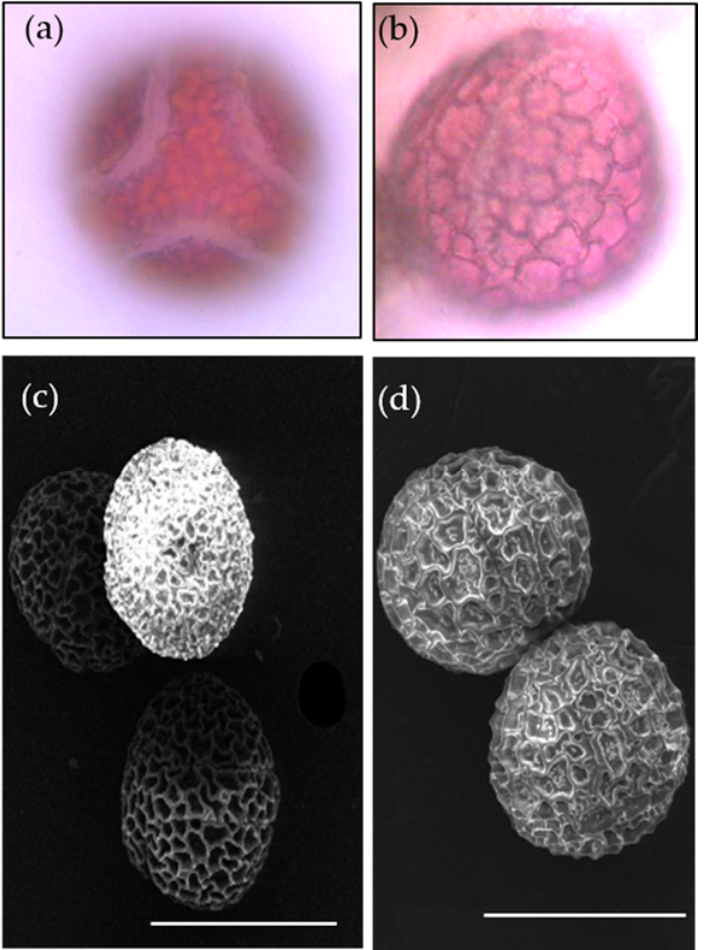
Figure 10. Pollen morphology of P. foetida ( a , c ) and P. edulis ( b , d ) viewed under light microscope and scanning electron microscope.